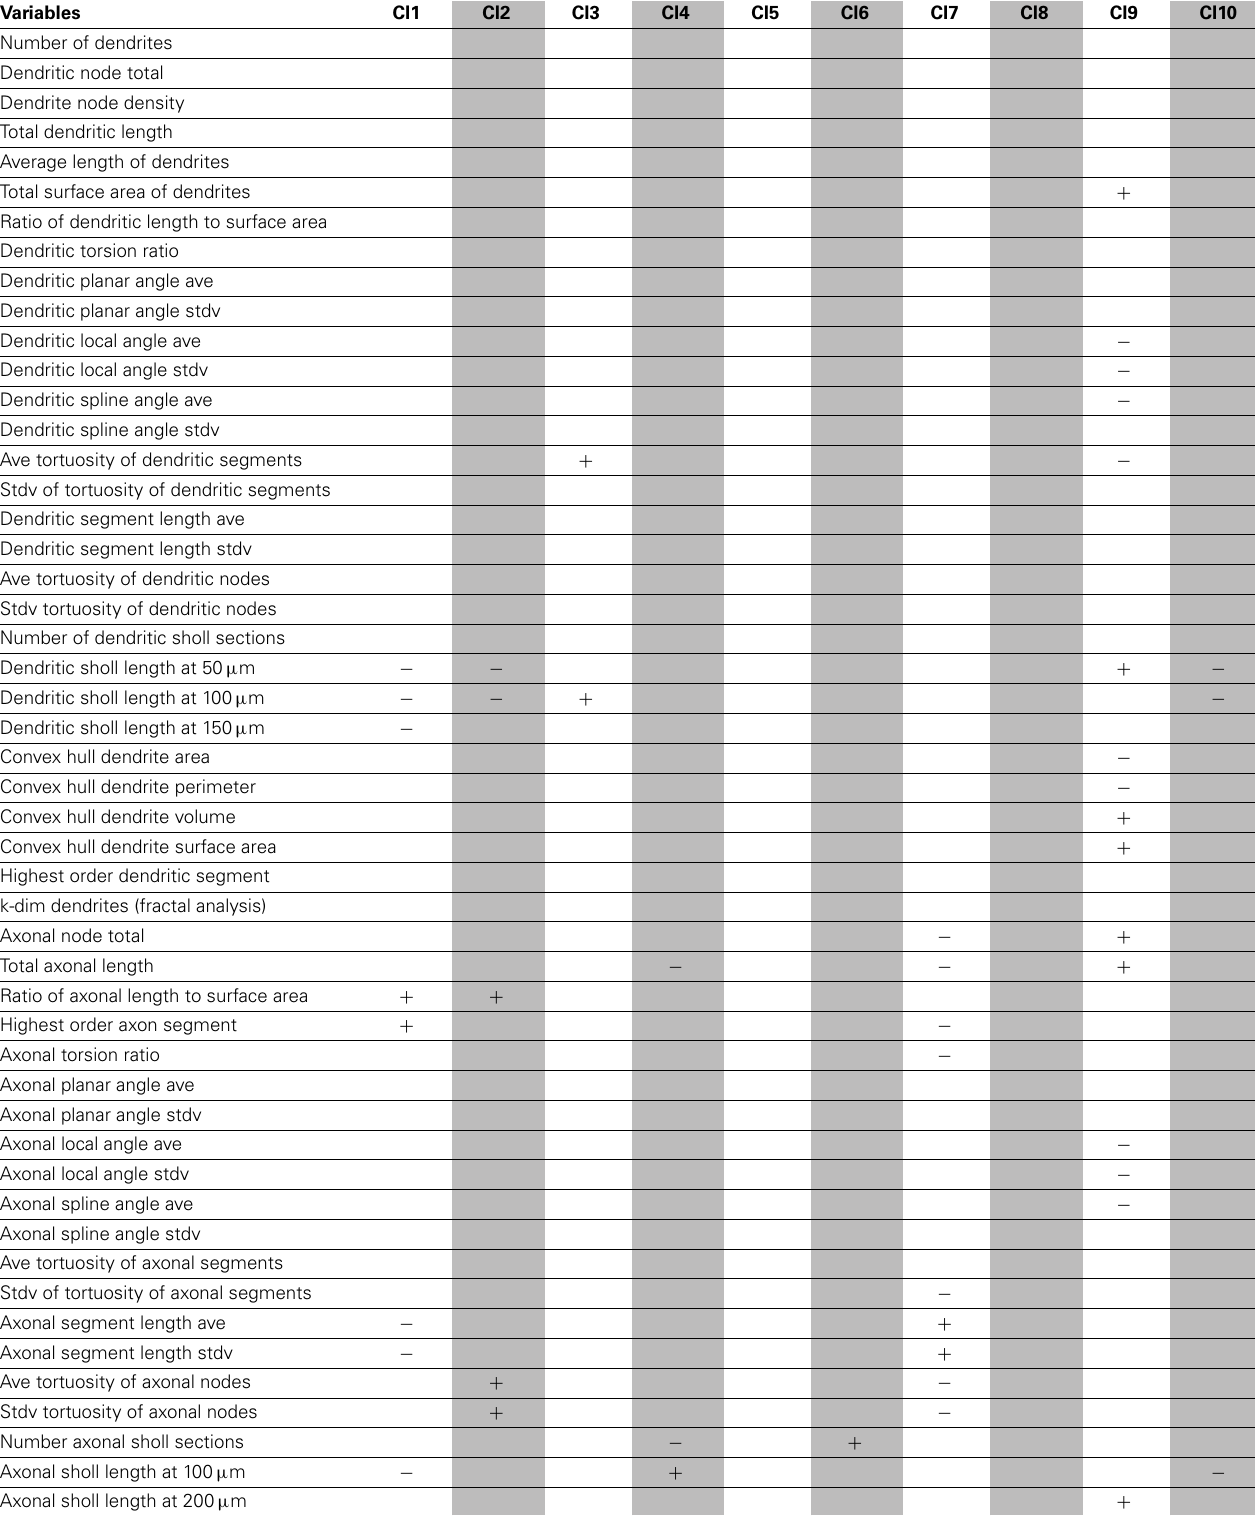
Table 2 | Significant variables for each morphological cluster. Variables